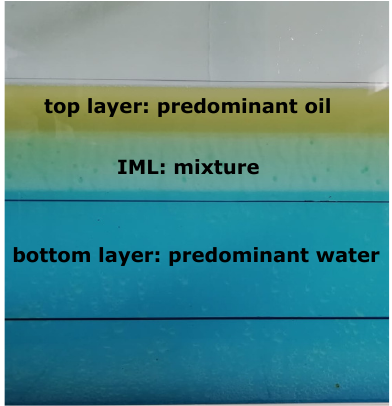
Figure 12. Layers in the horizontal reservoir permanently monitored by the vision